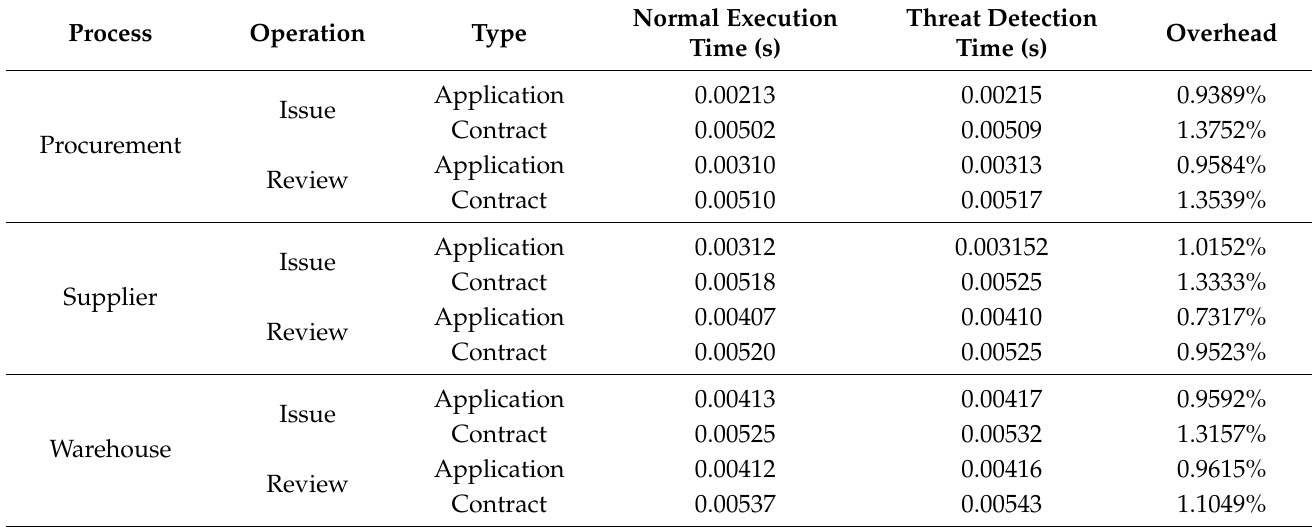
Table 3. Evaluation of external